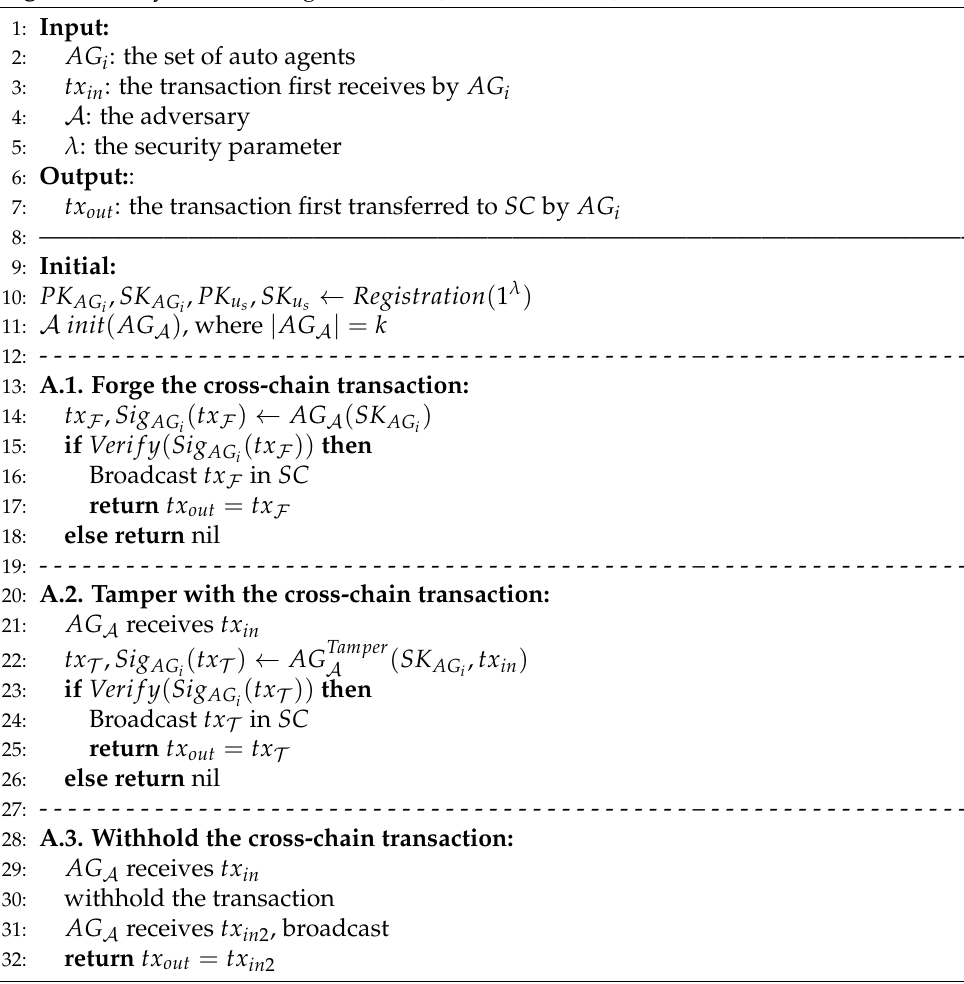
Algorithm 3 Sybil-resistant game G sybil (from AG i to SC